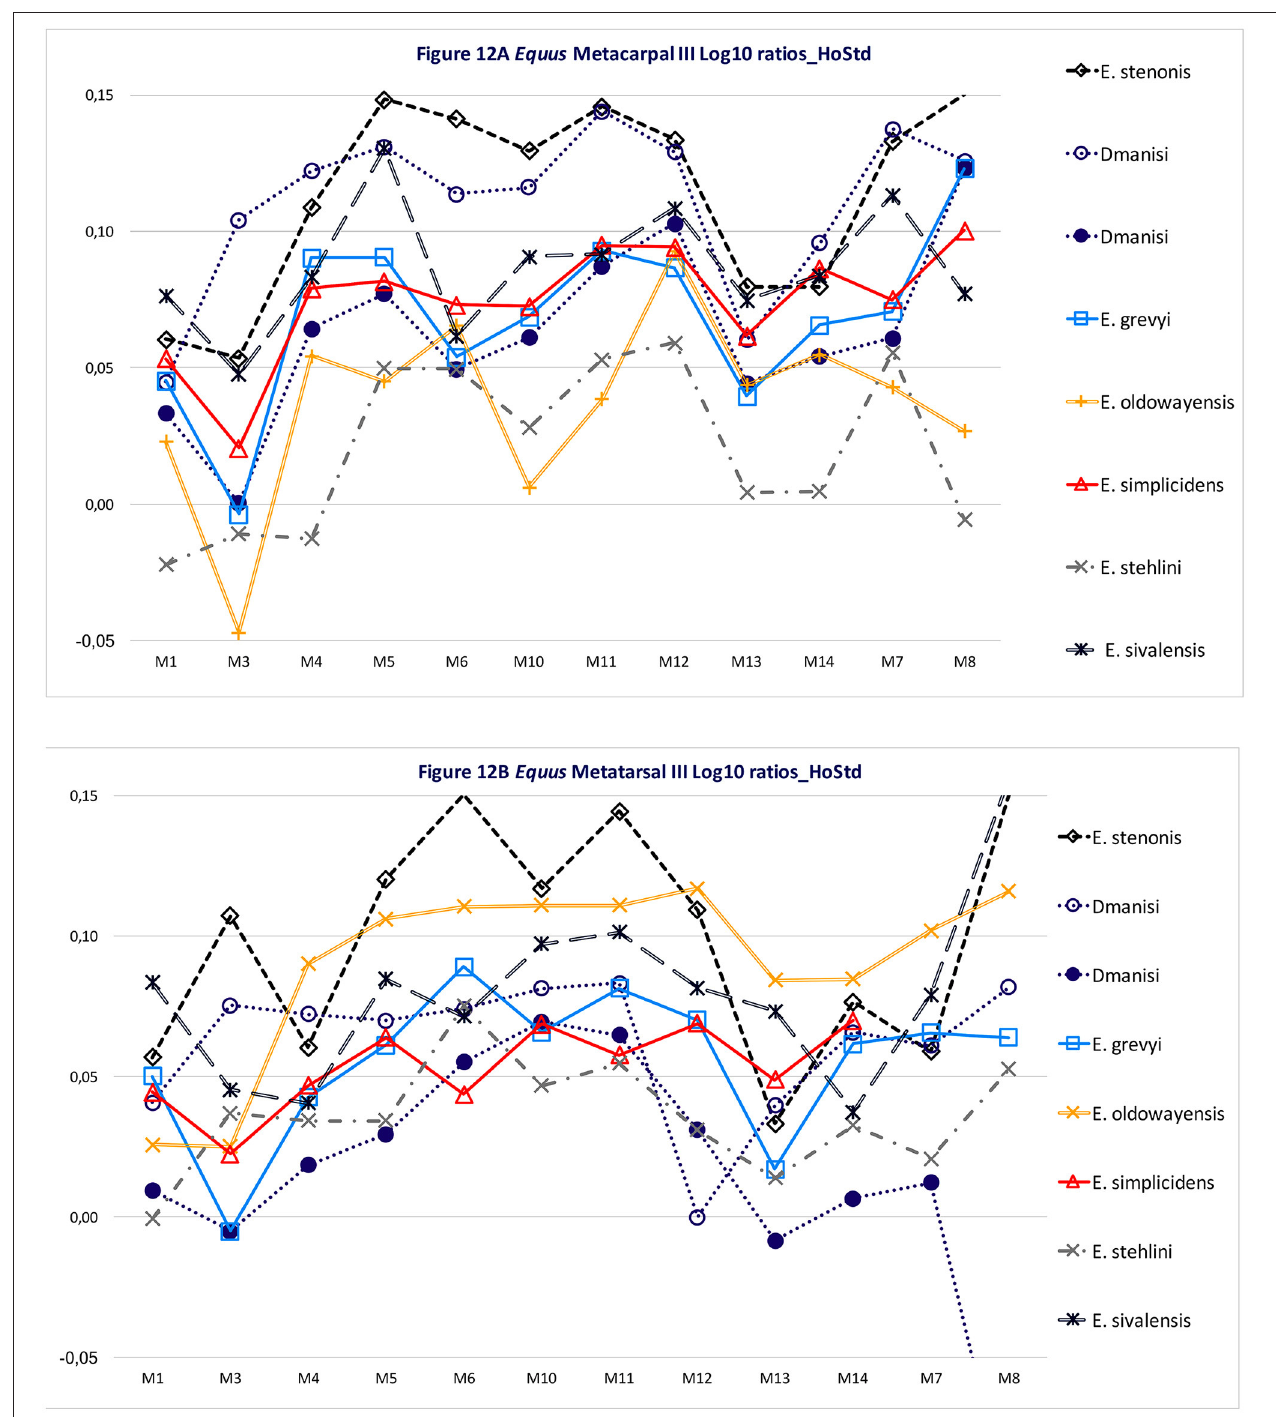
FIGURE 12 | Log10 ratio diagrams; the specimens are analyzed on the Hoewenegg Hippotherium primigenium sample. (A) Log10 ratio diagram of third metacarpal; (B) Log10 ratio diagram of third metatarsal.